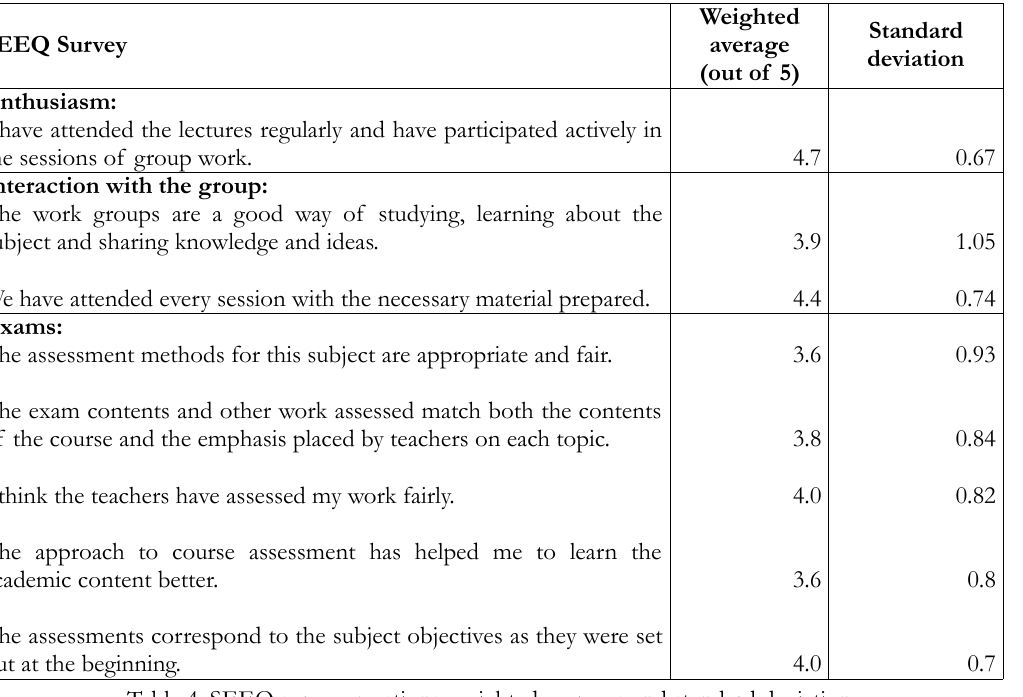
Table 4. SEEQ survey questions, weighted averages and standard